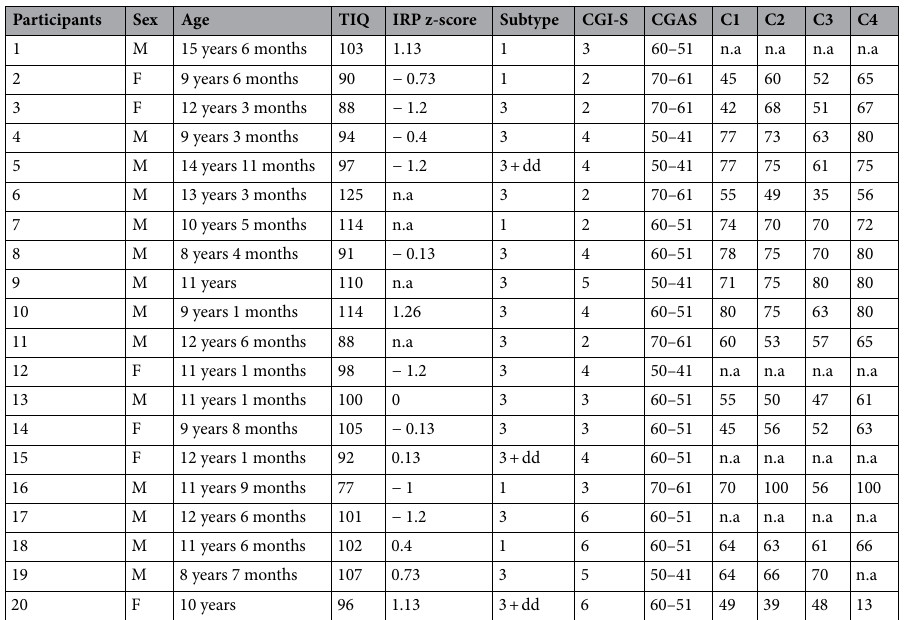
Table1. Descriptive characteristics of the ADHD group. TIQ Total Intelligence Quotient from WISC-IV, IRP z-score Visual Perceptual Reasoning from WISC-IV; Subtype 1 inattentive, 3 combined; dd developmental dyslexia, CGI Clinical Global Impression – Severity scale, CGAS Children Global Assessment Scale, C1 Conners parents oppositivity, C2 Conners parents inattanetion, C3 Conners parents hyperactivity, C4 Conners parents ADHD index, n.a. not